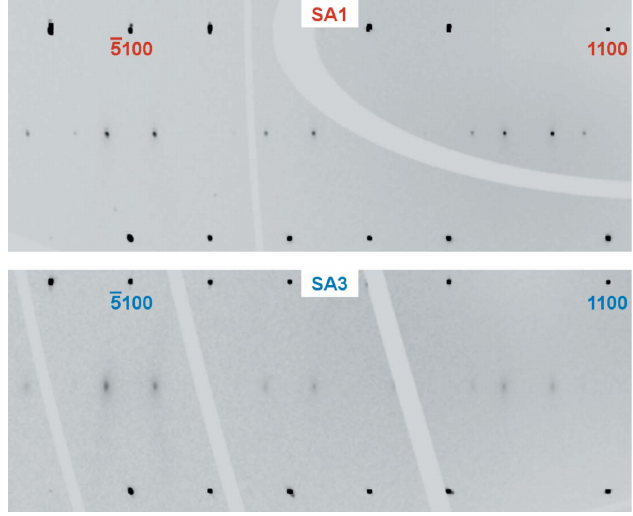
Figure 9 Parts of the h 1 l sections of SA1 and SA3, both from measurements on BM01, scaled for better comparison. Satellites of SA3 (bottom) appear weaker and more diffuse compared with SA1 (top) with sharp